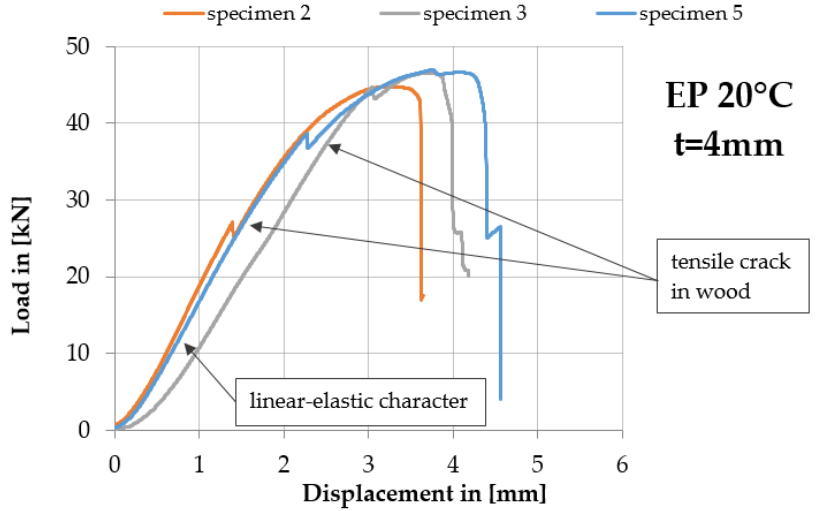
Figure 11. Force vs. displacement plot for selected specimens EP2579-1 double shear lap joint for the adhesive layer thickness t = 4 mm at 20 °C. Table 7. Shear test results for the double lap joint during compression at 80 °C.